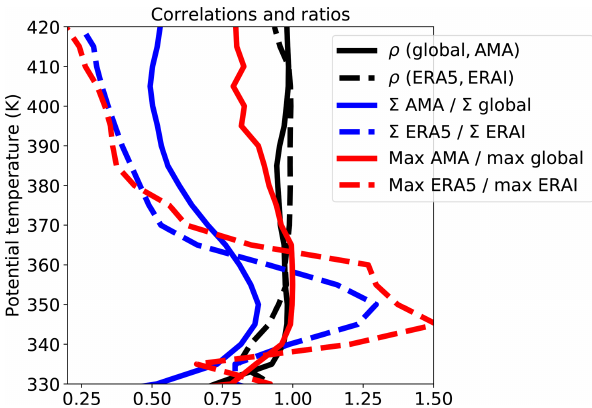
Figure 3. Solid back: correlation of the impact density between the FullAMA and global EID calculations within the FullAMA domain. Dashed black: same for EAD and EID FullAMA calculations. Solid blue: ratio of maximum impacts between the FullAMA and global EID calculations within the FullAMA domain. Dashed blue: same for EAD and EID FullAMA calculations. Solid red: ratio of cumu- lated impacts between the FullAMA and global EID calculations within the FullAMA domain. Dashed red: same for EAD and EID FullAMA calculations.